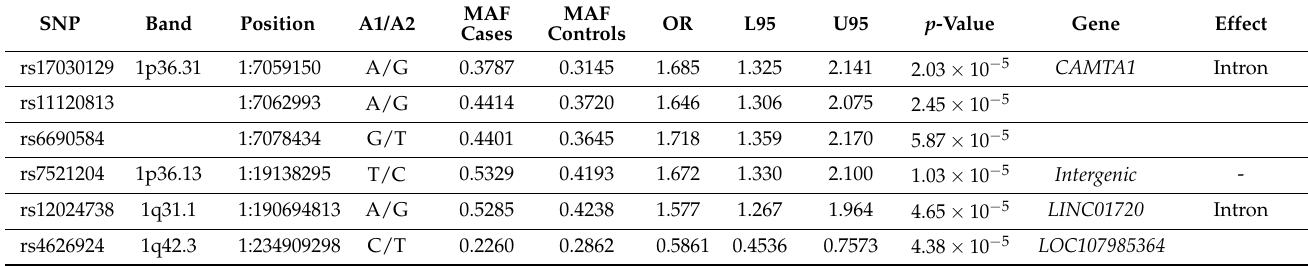
Table 2. Associated SNPs to disordered eating in Mexican